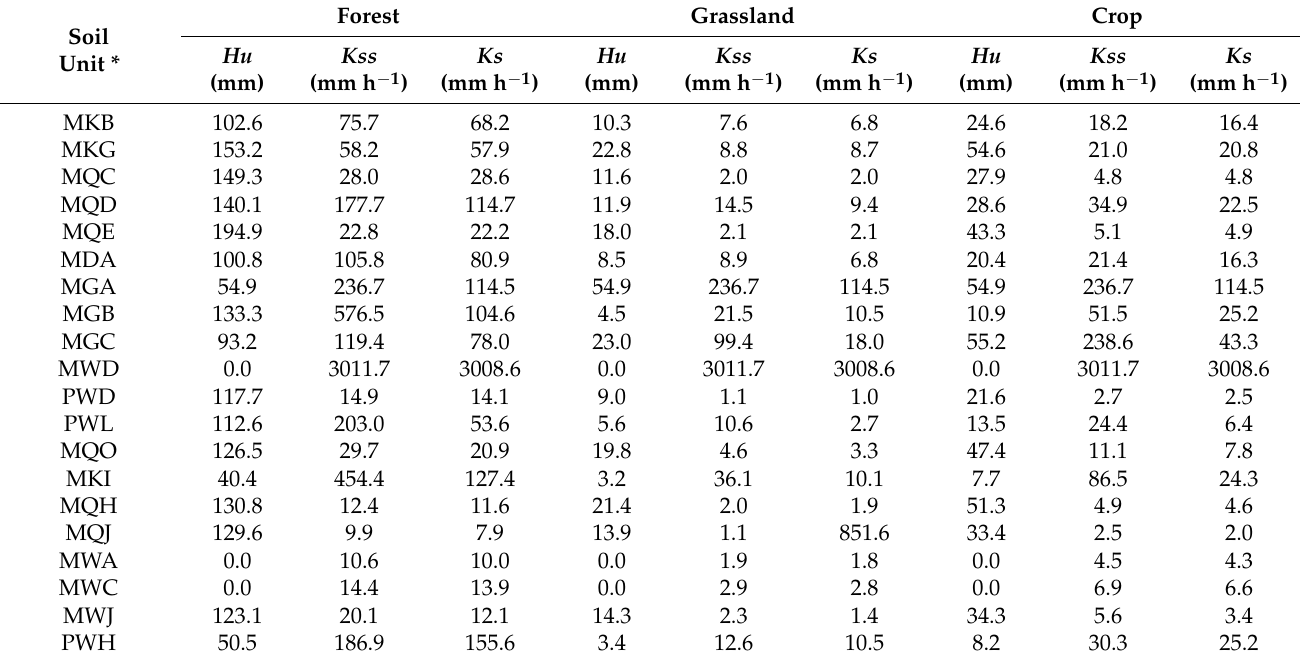
Table 1. Modal values of the hydraulic properties of soils in the Combeima river basin, Colombia, reported by Peña et al. (2016) [28]. * Taxonomic classification of soils defined by the United States Department of Agriculture (USDA)